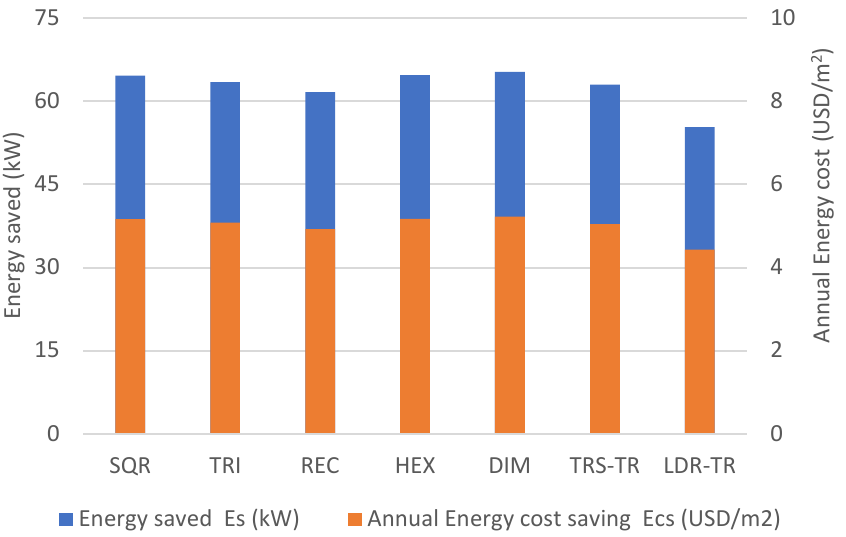
Figure 11. Energy saved and associated electricity cost ($0.08/kWh) using different 3DPC infill structures versus a concrete brick wall.